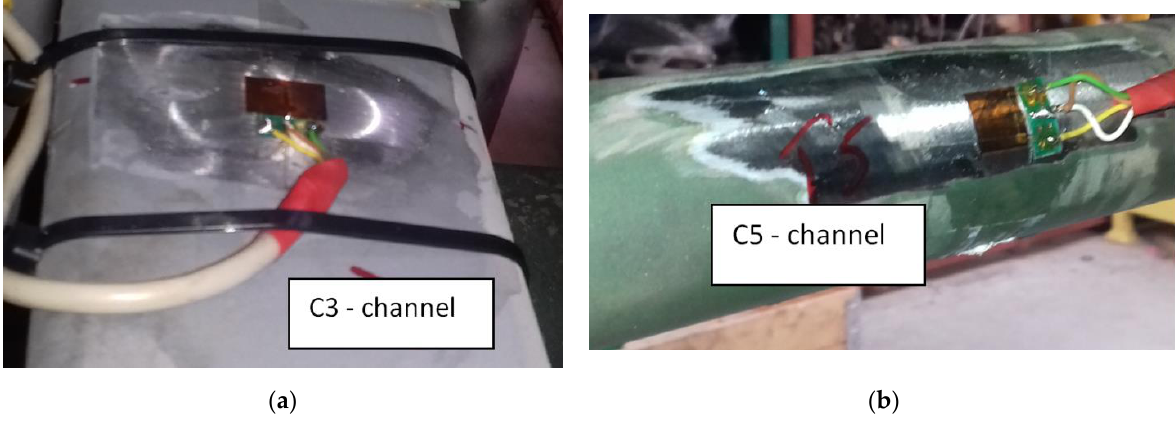
Figure 5. View of developed test points ( a ) on the leaf spring; ( b ) on the stabilizer bar. In the case of the C 1, C 2, C 3, and C 5 measuring tracks, the first direction of strain measurement at the measuring point was in accordance with the direction of stress 𝜎 𝐵 due to bending of the spring blade. The second direction of strain measurement at the measuring point was perpendicular to the first direction. The strain measurement fields were in the middle of the spring leaf width, and the effect of spring leaf torsion was compensated within the pair of active strain gauges. The post-conversion value 𝑤 𝐵 in the measurement paths of the springs can be calculated from the relation.